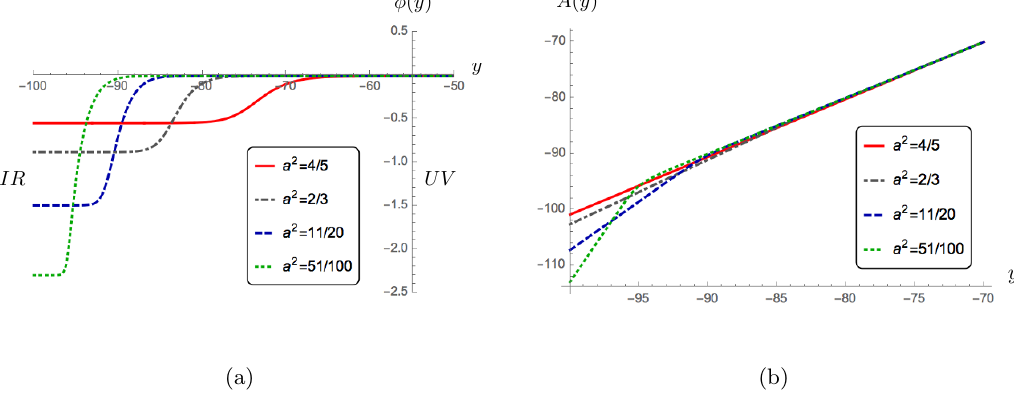
Figure 2 . (Colour online) (a) The solutions (cid:30) connecting the two conformal (cid:12)xed points for several di(cid:11)erent parameters a . (b) The domain wall behaviour of the metric function A ( y ) for the di(cid:11)erent parameter a